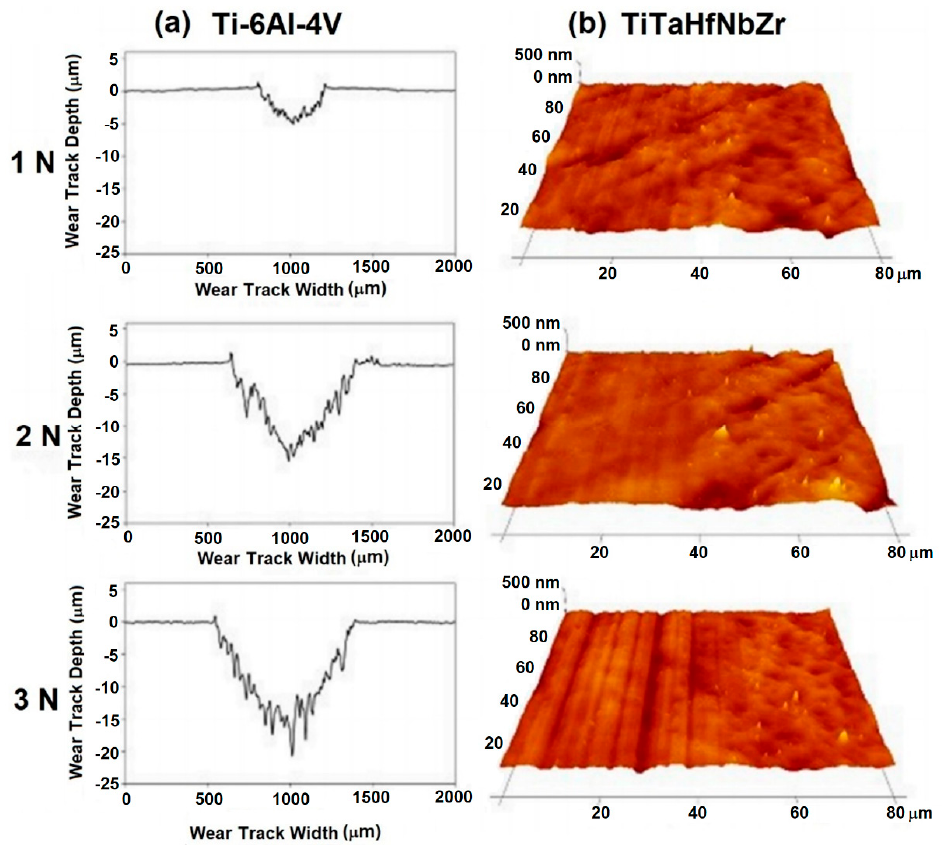
Figure 4. ( a ) Wear track profiles of Ti-6Al-4V and ( b ) AFM images of 800 nm thick TiTaHfNbZr HEA coatings at different loads [67]. Copyright 2019